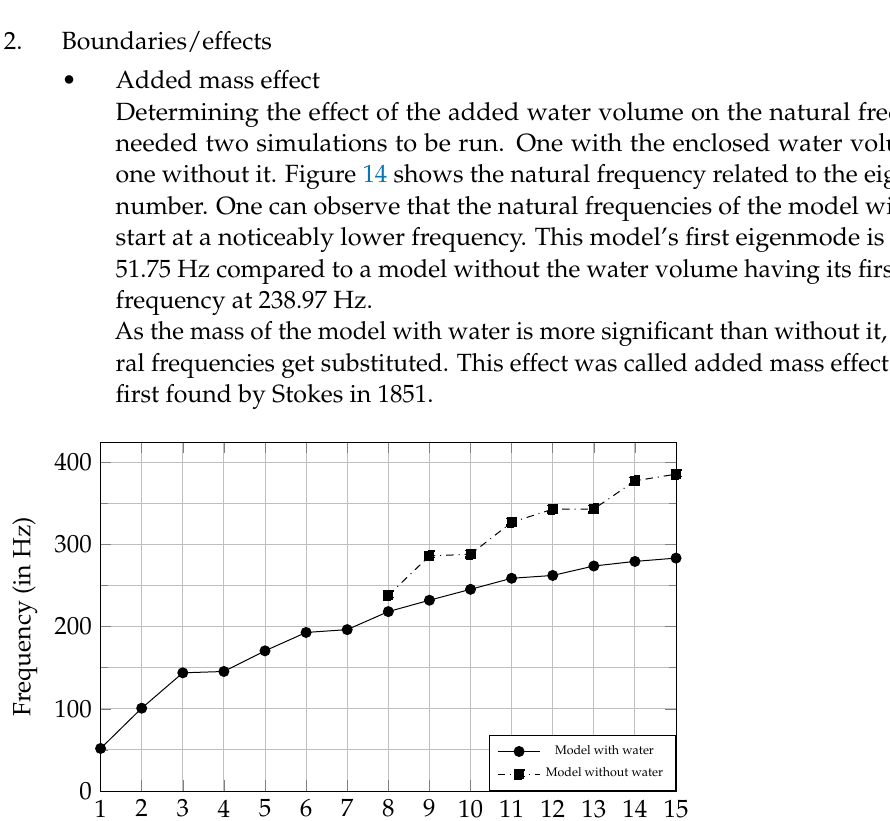
Figure 13. FE model of the draft tube.